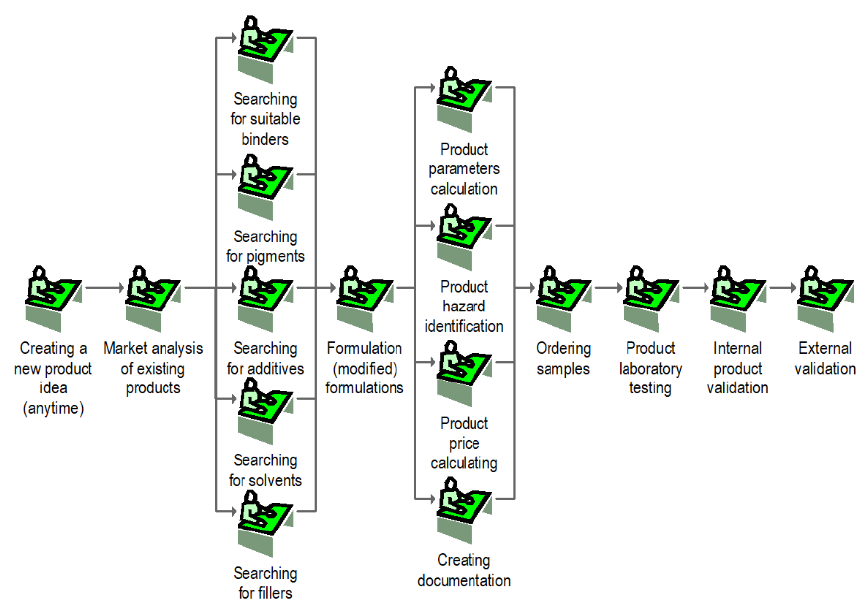
Scheme 2. The model overview of the modified (redesigned) new product development process after digital transformation. Table 2. Key activities of the new product development process after the digital transformation. New Product Development Process after Digital